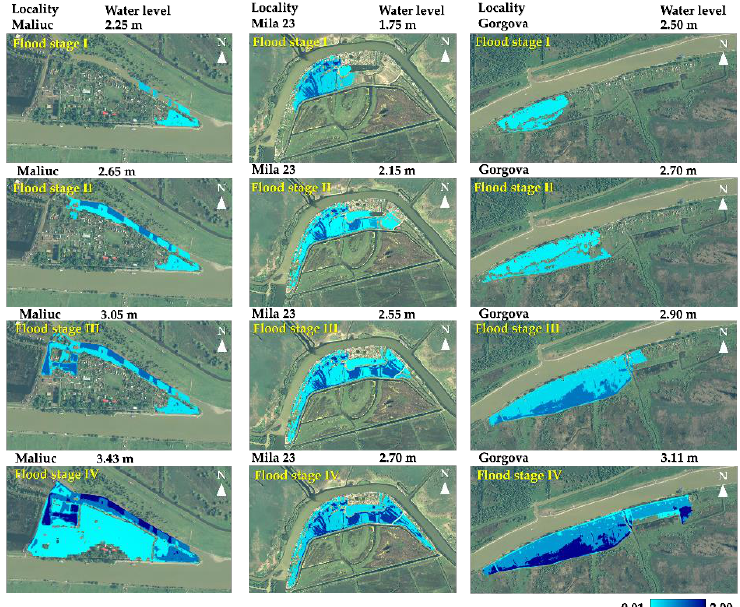
Figure 12. Flood scenarios maps for Maliuc (first column group of subfigures), Mila 23 (second column group of subfigures), and Gorgova (third column group of subfigures) settlements, corresponding to the condition of 7 July 2010, by using the 1D / 2D HEC-RAS model, at high resolution DTM 0.5 m × 0.5 m, dynamic method.